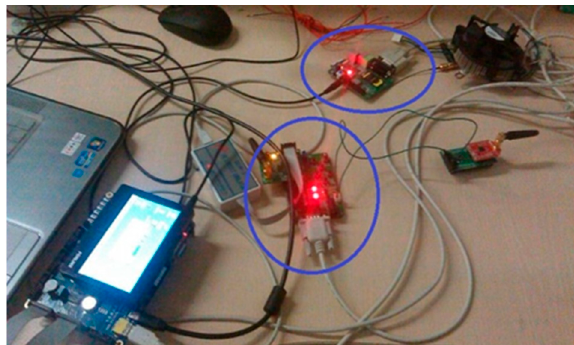
Figure 5. The specially designed mobile device.